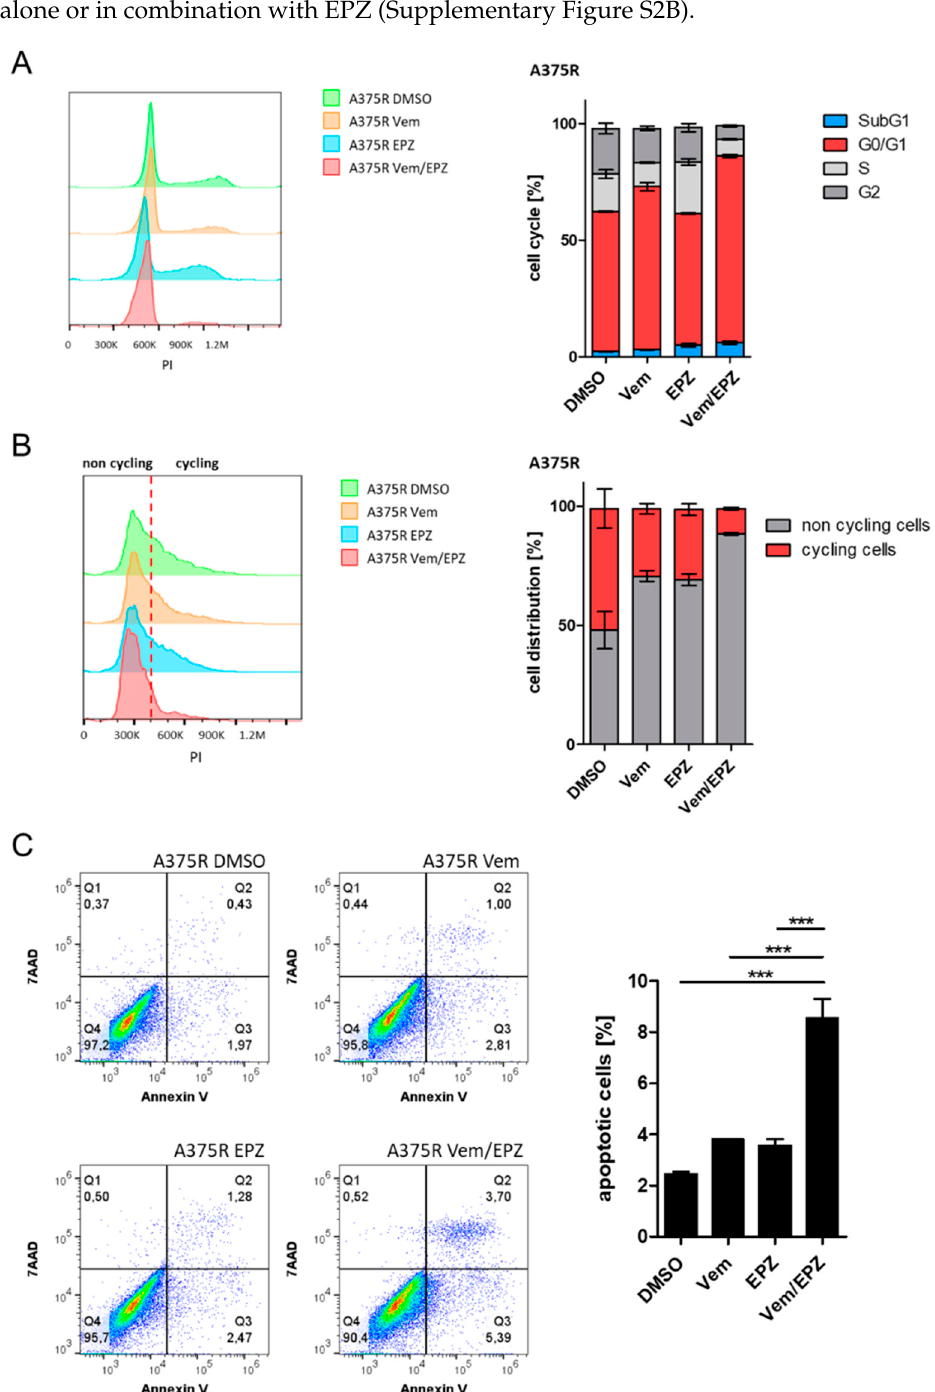
Figure 3. Combination of vemurafenib and EPZ enhances G0/G1 phase arrest and apoptosis in A375R cells. Cell-cycle analyses of A375R cells treated with DMSO, vemurafenib (Vem) (10 µM), EPZ (5 µM) or vemurafenib and EPZ in combination for 72 h. ( A ) Histogram and bar chart represent cell-cycle analyses of treated A375R cells. ( B ) Histogram and bar chart represent cycling and non-cycling cells after serum starvation and treatment as described above. ( C ) Analysis of apoptosis for A375R cells treated as indicated. (*** p < 0.001).